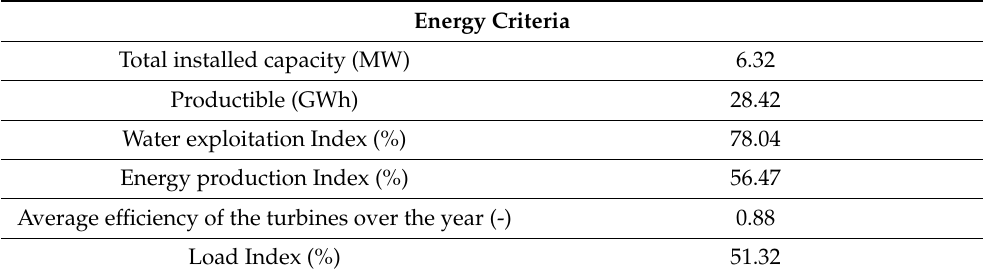
Table 14. Energy criteria.